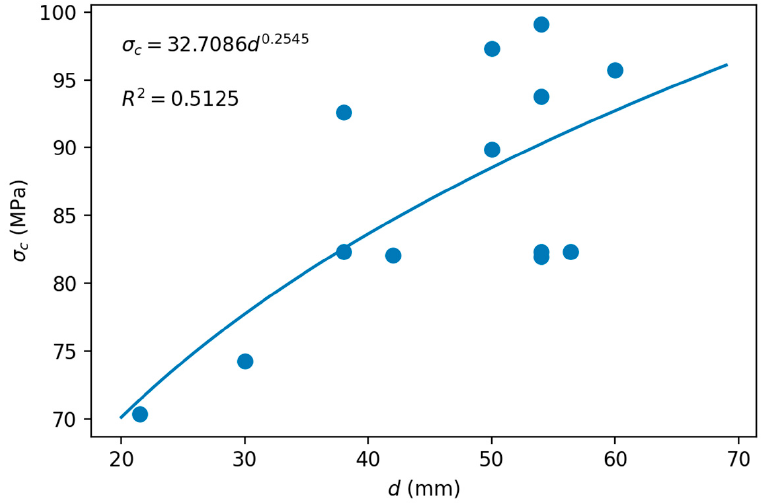
Figure 7. Least squares adjustment to estimate the σ c (50) of the scale effect of the limestone.